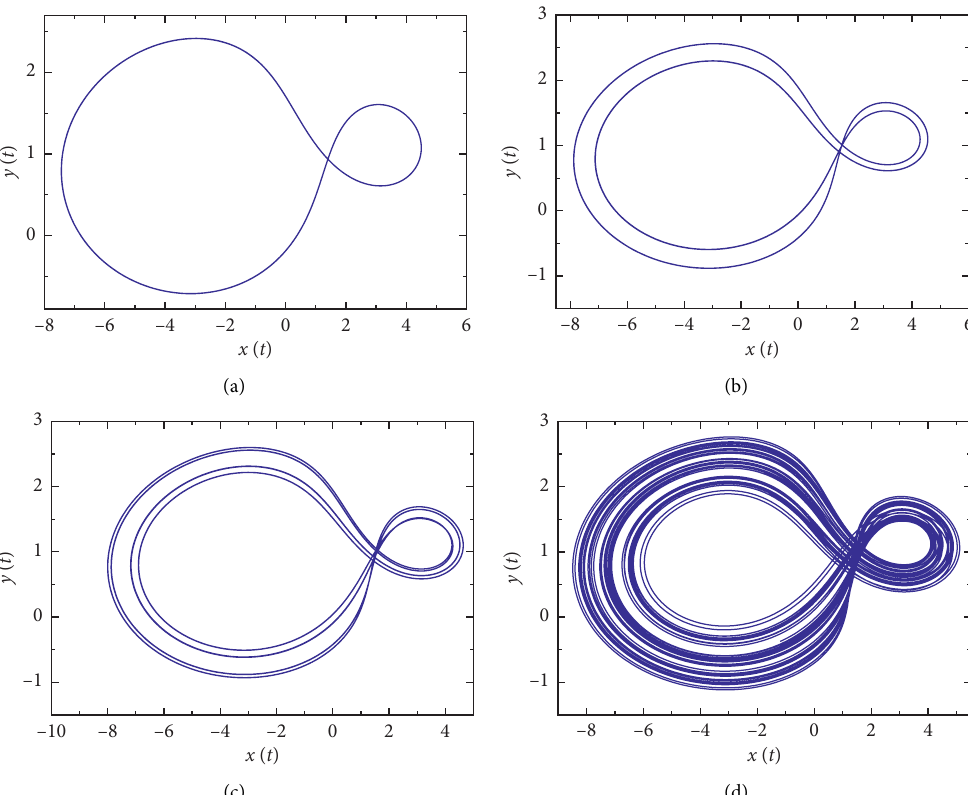
Figure 9: Phase diagrams showing the period-doubling route to chaos for system (6) with q � 0 . 87, (c) q � 0 . 878, and (d) q (b) q 3 3